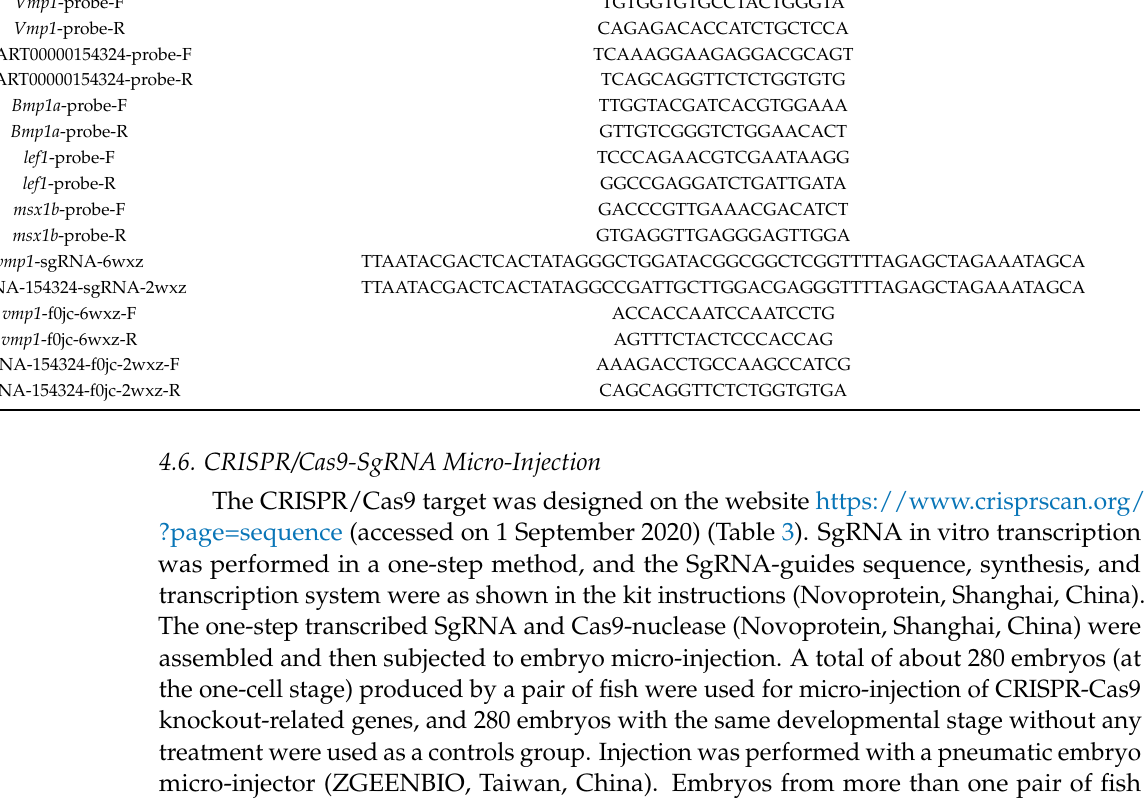
Table 3. The sequences of the probes and CRISPR/Cas9-sgRNA primers used in this study. Primers Primer Sequences (5 (cid:48) → 3 (cid:48)